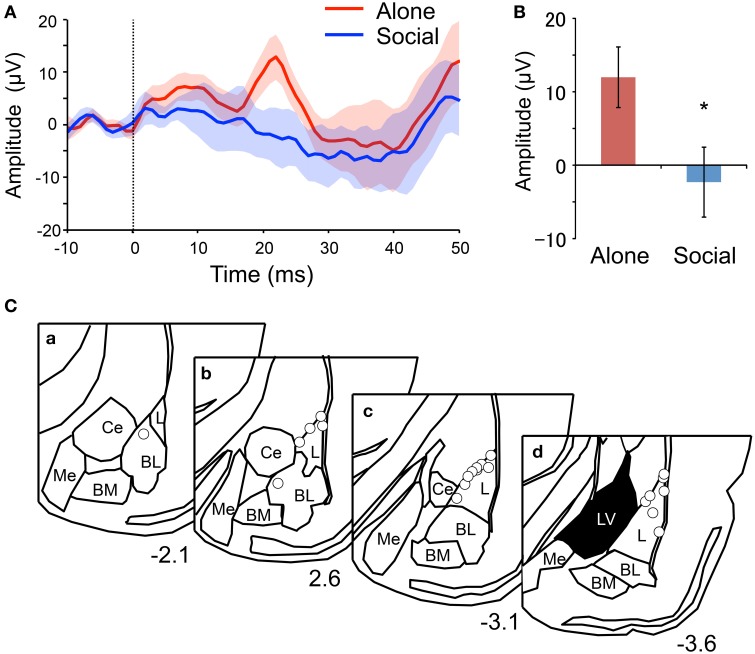
Reduction of mean peak amplitude of the auditory evoked field potentials (AEFPs) in the Social condition. (A) Averaged AEFPs in the Alone (red) and Social (blue) conditions. The dotted line indicates CS onset. The solid lines and translucent areas indicate the means and SEMs, respectively. (B) Comparison of the mean peak amplitudes (averaged voltages between 21 and 23 ms after CS onset) between the conditions. *P < 0.05, unpaired t-test. (C) Locations of AEFP-recording electrodes. Circles indicate the locations. The value below each section indicates distance (mm) from the bregma. L, lateral amygdala; BL, basolateral amygdala; BM, basomedial amygdala; Me, medial amygdala; Ce, central amygdala; LV, lateral ventricle.